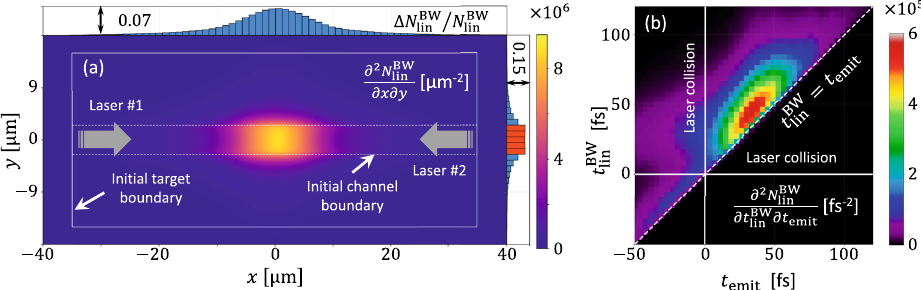
Fig. 5 Distribution of linear Breit – Wheeler pairs upon their creation. a Probability density that an electron – positron pair is created by the linear Breit – Wheeler process at longitudinal and transverse coordinate x and y . The density integrated over x ( y ), and normalized to the total number of pairs,